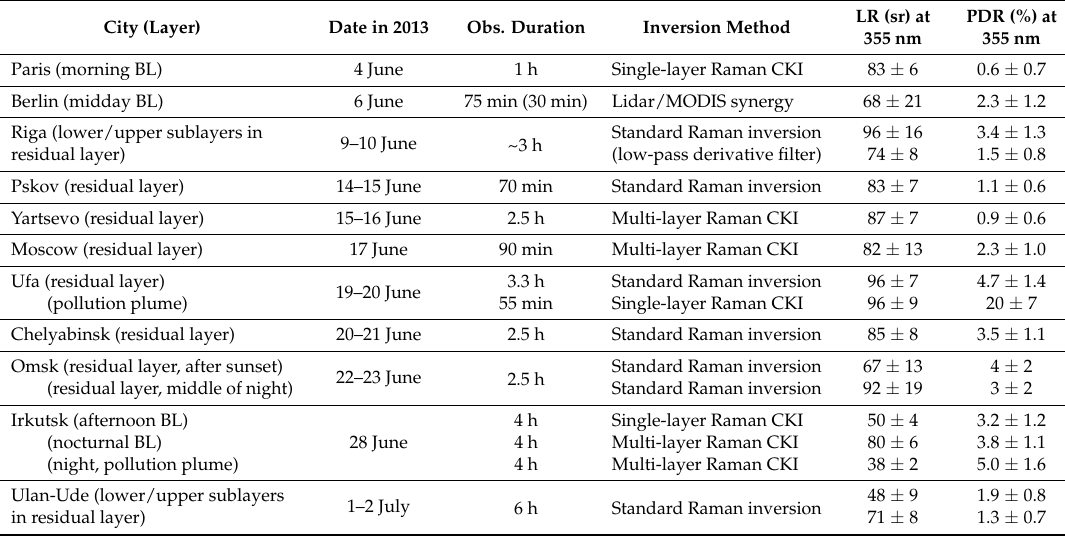
Table 2. Values of the Lidar Ratio (LR) and linear Particle Depolarization Ratio (PDR) at 355 nm (average and 1- σ standard deviation), as observed with the mobile lidar over the 11 cities during this campaign, along with the inversion method used (CKI stands for Constrained Klett